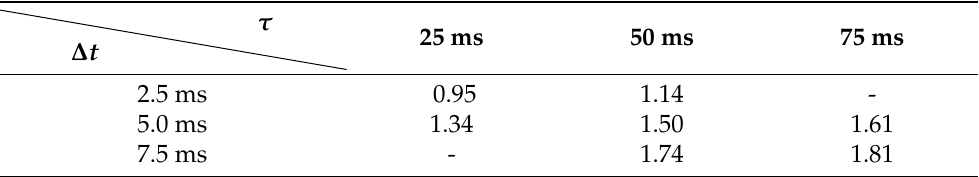
Table 2. Results of study on hyperparameters, ∆ t and τ . The evaluation metric is average end-point error (AEE) (pix/ ∆ t